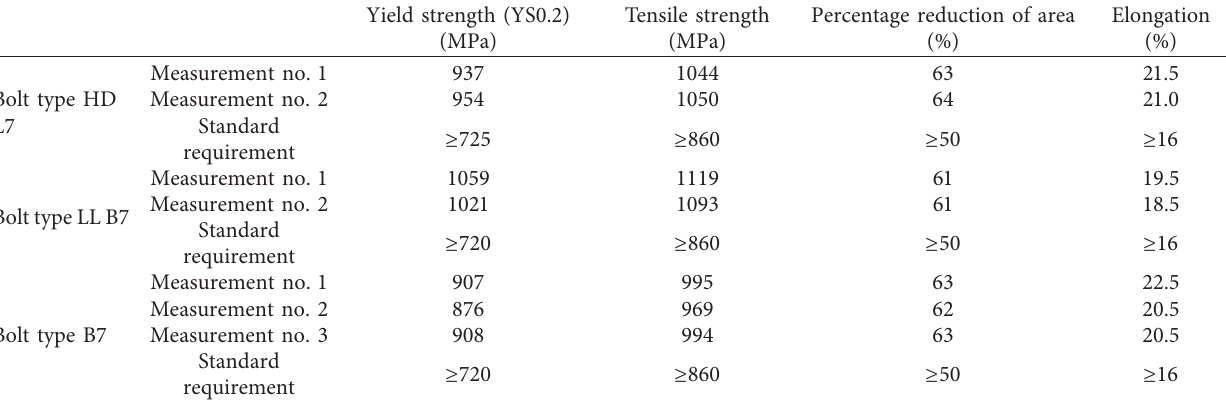
Table 4: Testing results of bolt tensile properties.